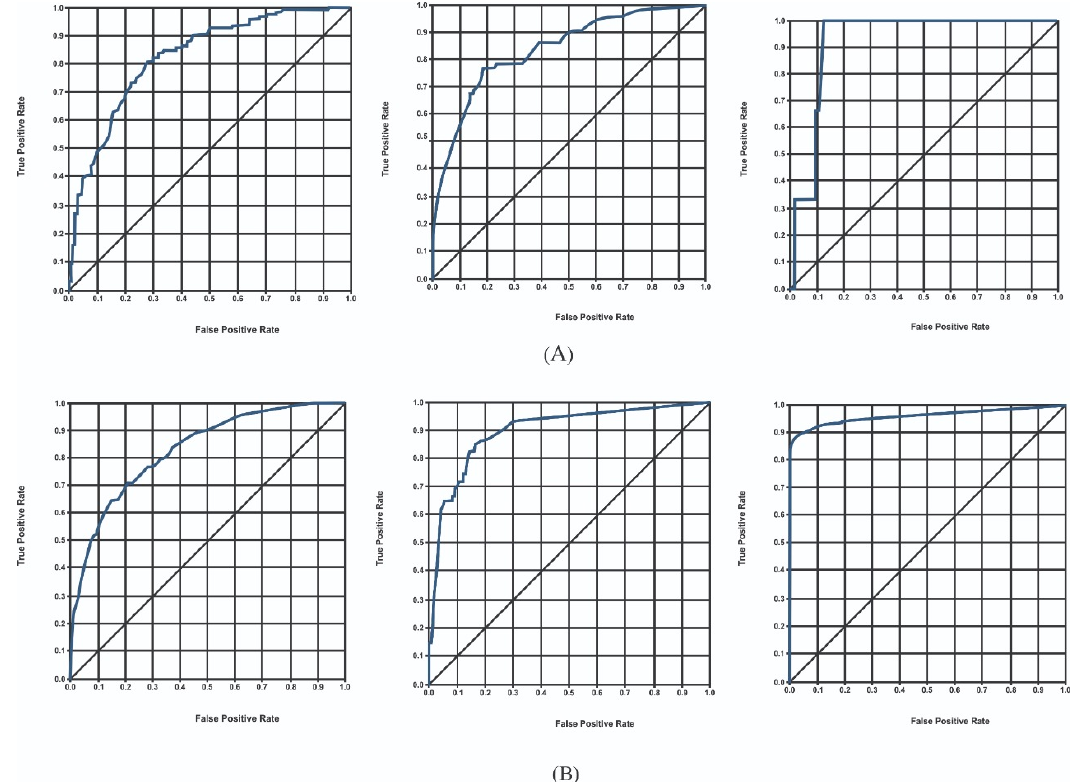
Figure 7. ( A ) ROC curve obtained using AlexNet, InceptionV3, and RegNetY-320 with a learning rate of 0.01; ( B ) ROC curve obtained using AlexNet, InceptionV3, and RegNetY-320 with a learning rate of 0.001.